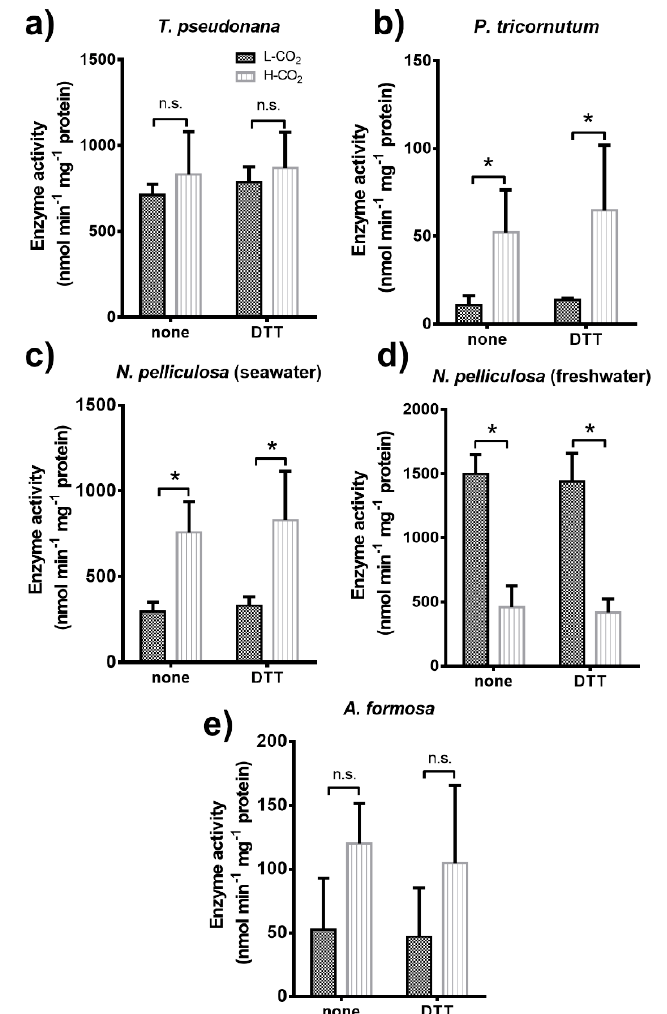
Figure 5. Phosphoglycerate kinase (PGK) activity in diatoms ( a – e ). All panels show activity measurements of diatom crude protein extracts from cultures grown at low CO 2 (L-CO 2 ; 400 ppm, dark grey bars) or high CO 2 (H-CO 2 ; 20,000 ppm, light grey and dashed bars), as specified in panel ( a ), and without any treatment (none) or treated with 5 mM DTT prior to assay. Average and error bars (SD) are represented (n = 3). * p ≤ 0.05 and ns, not significant.